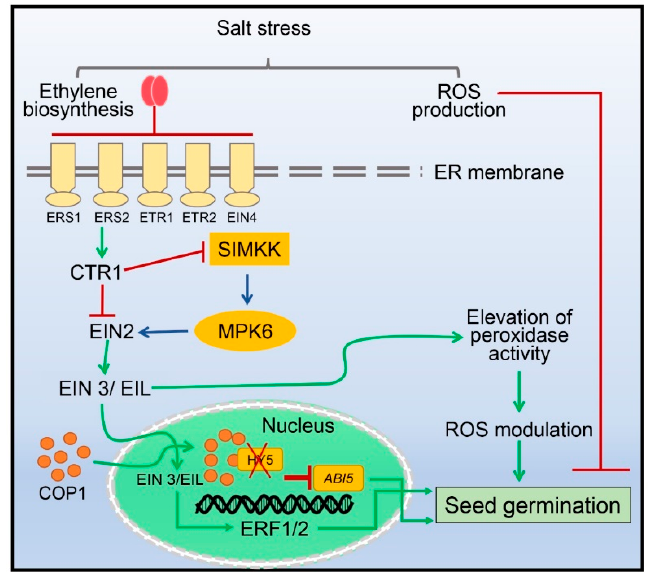
Figure 1. Role of ethylene signaling in seed germination under salinity stress. Ethylene induced by salinity stress activates the signaling pathway by inhibiting the active receptors and by releasing the Constitutive Triple Response1 (CTR1). Salinity-induced ethylene signal is transduced mainly through the classical receptors–CTR1-Ethylene-Insensitive2 (EIN2)-EIN3 pathway to regulate many effectors involved in plant growth and salinity response. EIN3/EIN3-Like (EIL) promotes the entry of Constitutive Photomorphogenesis1 (COP1) into the nucleus and degrades the Elongated Hypocotyl5 (HY5) protein, which inhibits seed germination by upregulating ABI5 gene expression. Degradation of HY5 inhibits the expression of ABI5 and ultimately induced seed germination under salinity stress. On the other hand, EIN3/EIL also directly induces seed germination by scavenging reactive oxygen species (ROS) through upregulating peroxidase activities.